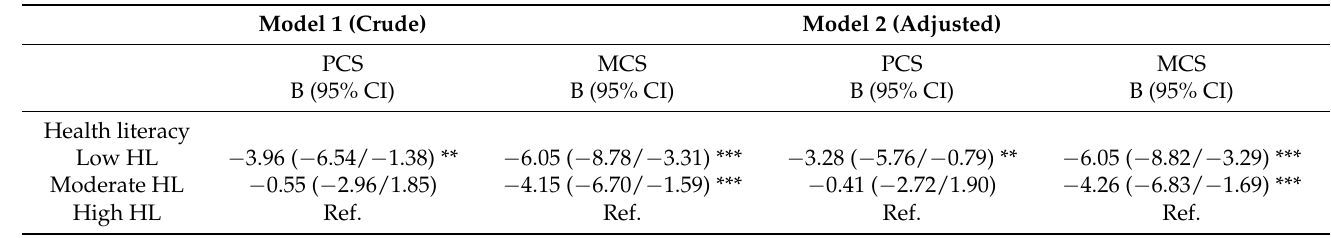
Table 2. Association of health literacy with PCS and MCS, crude effect (Model 1) and adjusted